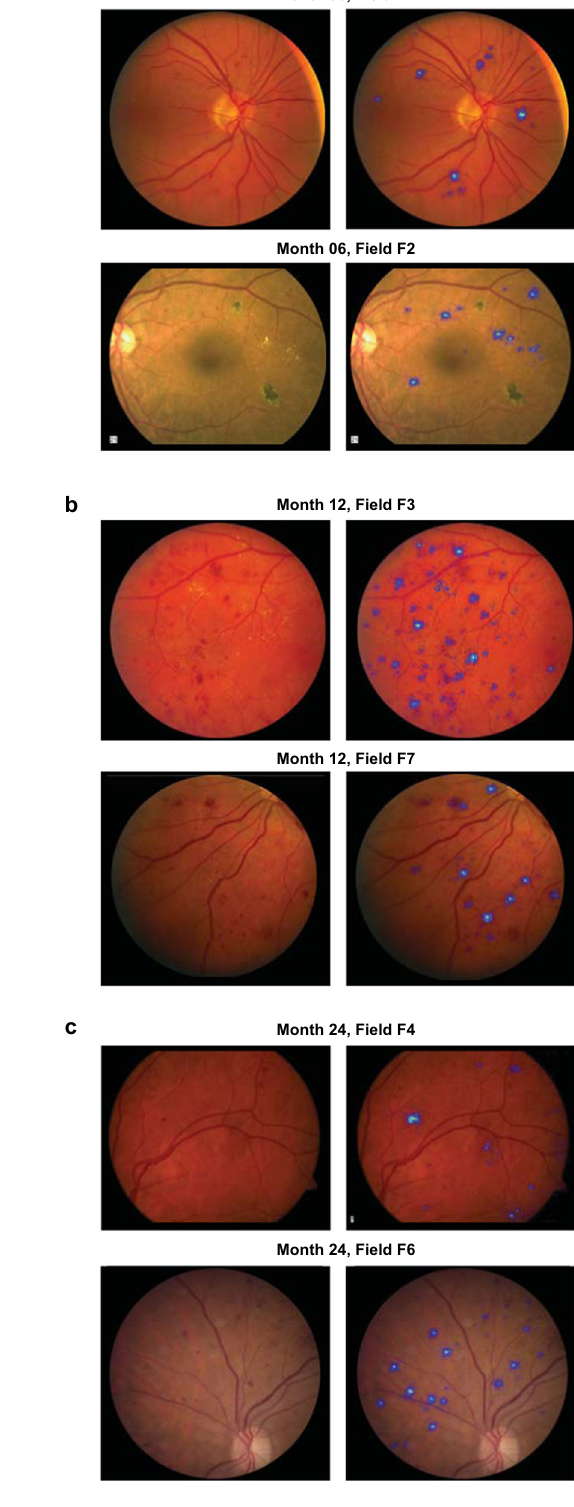
Fig. 4 Examples of attribution maps for each month and various types of FOV computed on the hold-out sets.